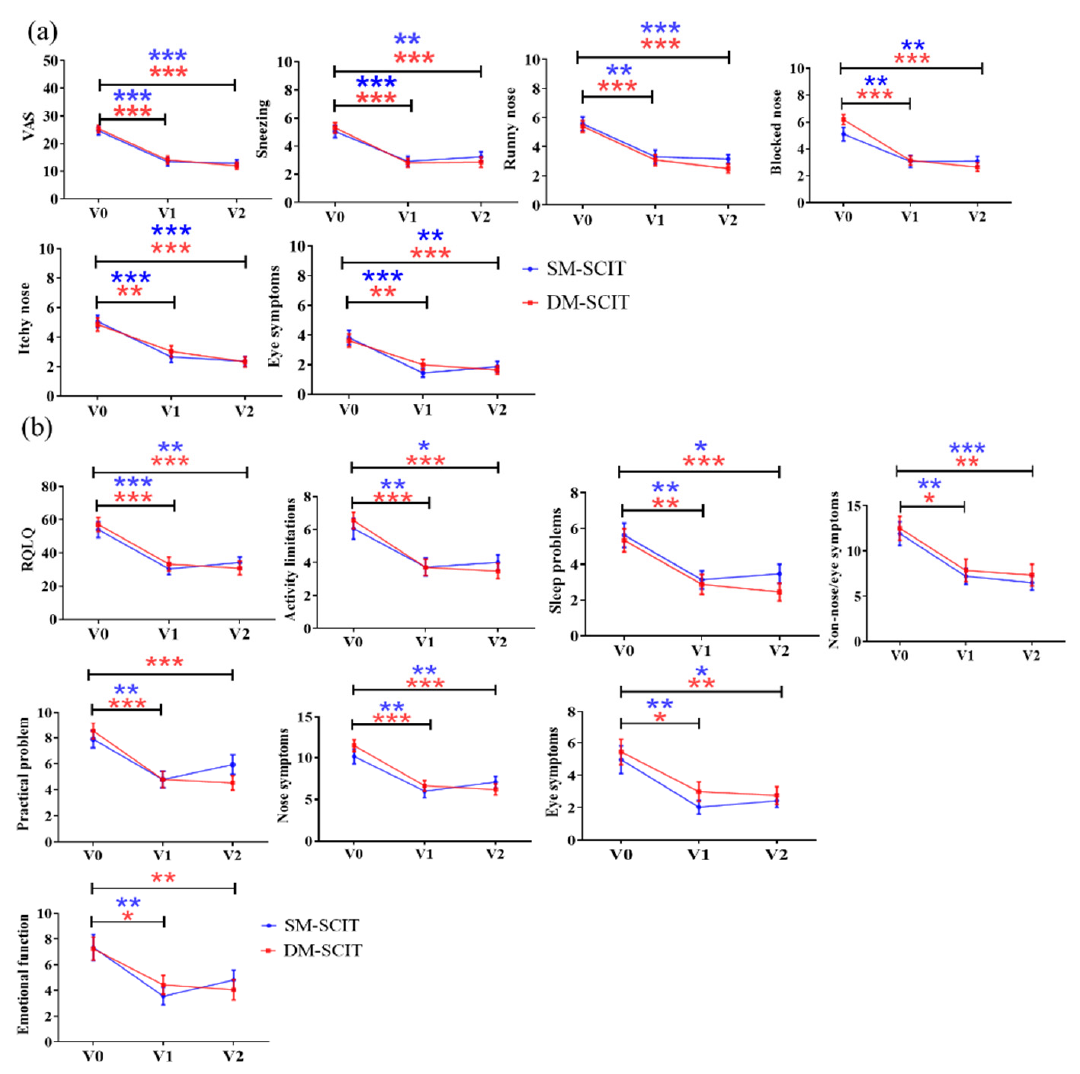
Figure 2. Comparison of two groups of questionnaire scores. ( a ) VAS scores. ( b ) RQLQ scores. Blue, SM-SCIT group; red, DM-SCIT group. All results were expressed as mean ± SEM (standard error of measurement). *, p < 0.05; **, p < 0.01; ***, p < 0.001.